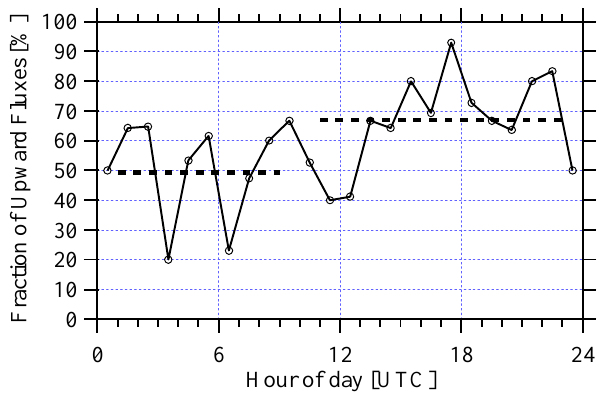
Figure 9. Fraction of upward fluxes by hour of day for 18 < D < 452 nm. Average values for 2 Fig. 9. Fraction of upward fluxes by hour of day for 18 < D < 452nm. Average values for night (01:00–09:00) and day (11:00– night (1:00-9:00) and day (11:00-23:00) also shown (dashed lines). 3 23:00) also shown (dashed lines).